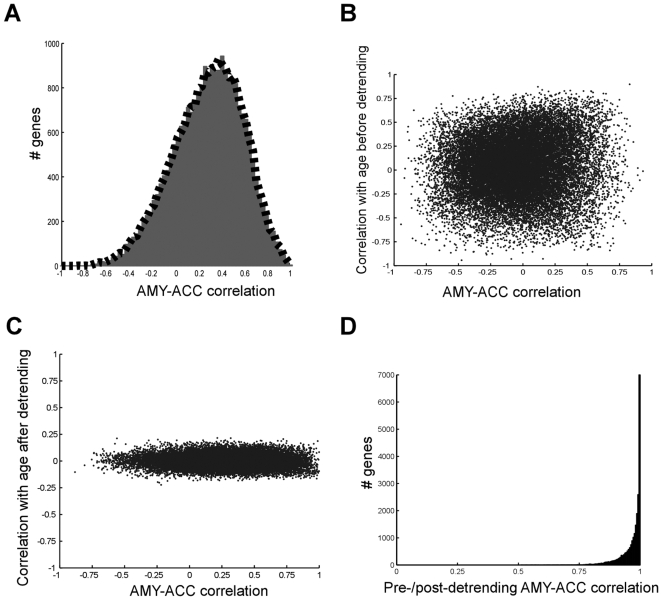
Age-related genes do not significantly influence gene coordination.
A Age-detrended bootstrapped estimates of gene coordination were significantly different from the null permutated model (p<.00001; distribution outlined by black dashed line) and did not decrease the overall levels of gene coordination, when compared to the original bootstrap estimates (red distribution). B–C Relationships between amygdala-cingulate coordination and age correlation, before (B) and after (C) removal of any age-correlation indicated that age-detrending did not affect amygdala-cingulate regional coordination. As shown in C, the distribution of age correlations is centered on zero and highly compressed compared to figure B. The residual spread in the y-axis is due to inevitable, small, randomly occurring correlations while resampling the detrended data. D Histogram of correlations between original and detrended amygdala-cingulate coordination levels, showing that the vast majority of genes retain highly similar regional correlation, thus demonstrating an overall very small contribution of age to regional gene synchrony.